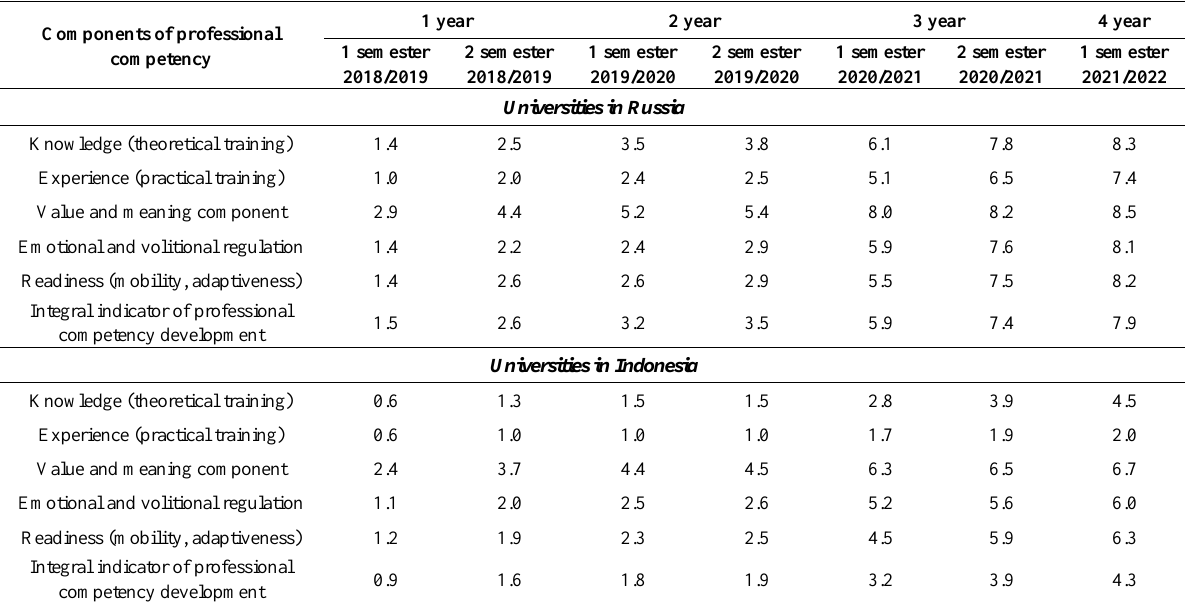
Table 2. Assessment of the students’ professional competencies development of Russian and Indonesian universities by the expert group (points) Components of professional